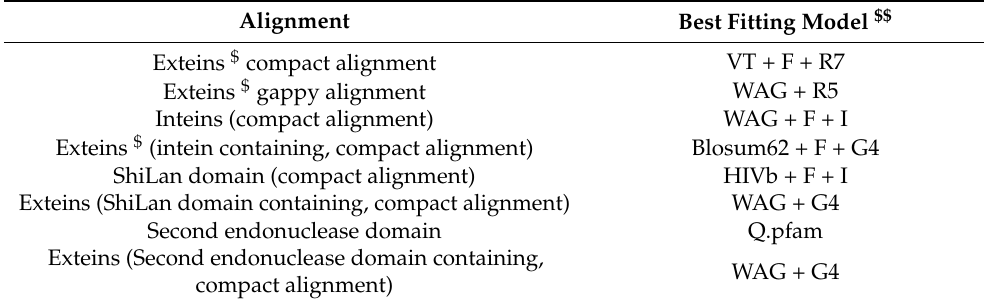
Table 1. Models selected by IQ-TREE using the Bayesian information criterion (BIC) for the different datasets. Alignment Best Fitting Model $$ Exteins $ compact alignment VT + F + R7 Exteins $ gappy alignment WAG + R5 Inteins (compact alignment) WAG + F + I Blosum62 + F +